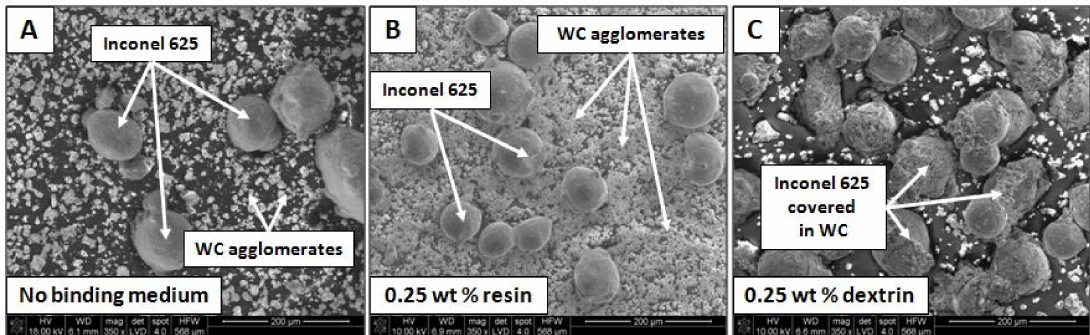
Figure 1. Scanning electron microscopy (SEM) images of powder mixture after each stage of homogenization: ( A ) no binder, ( B ) 0.25 wt% of resin binder, ( C ) 0.25 wt% of dextrin binder.